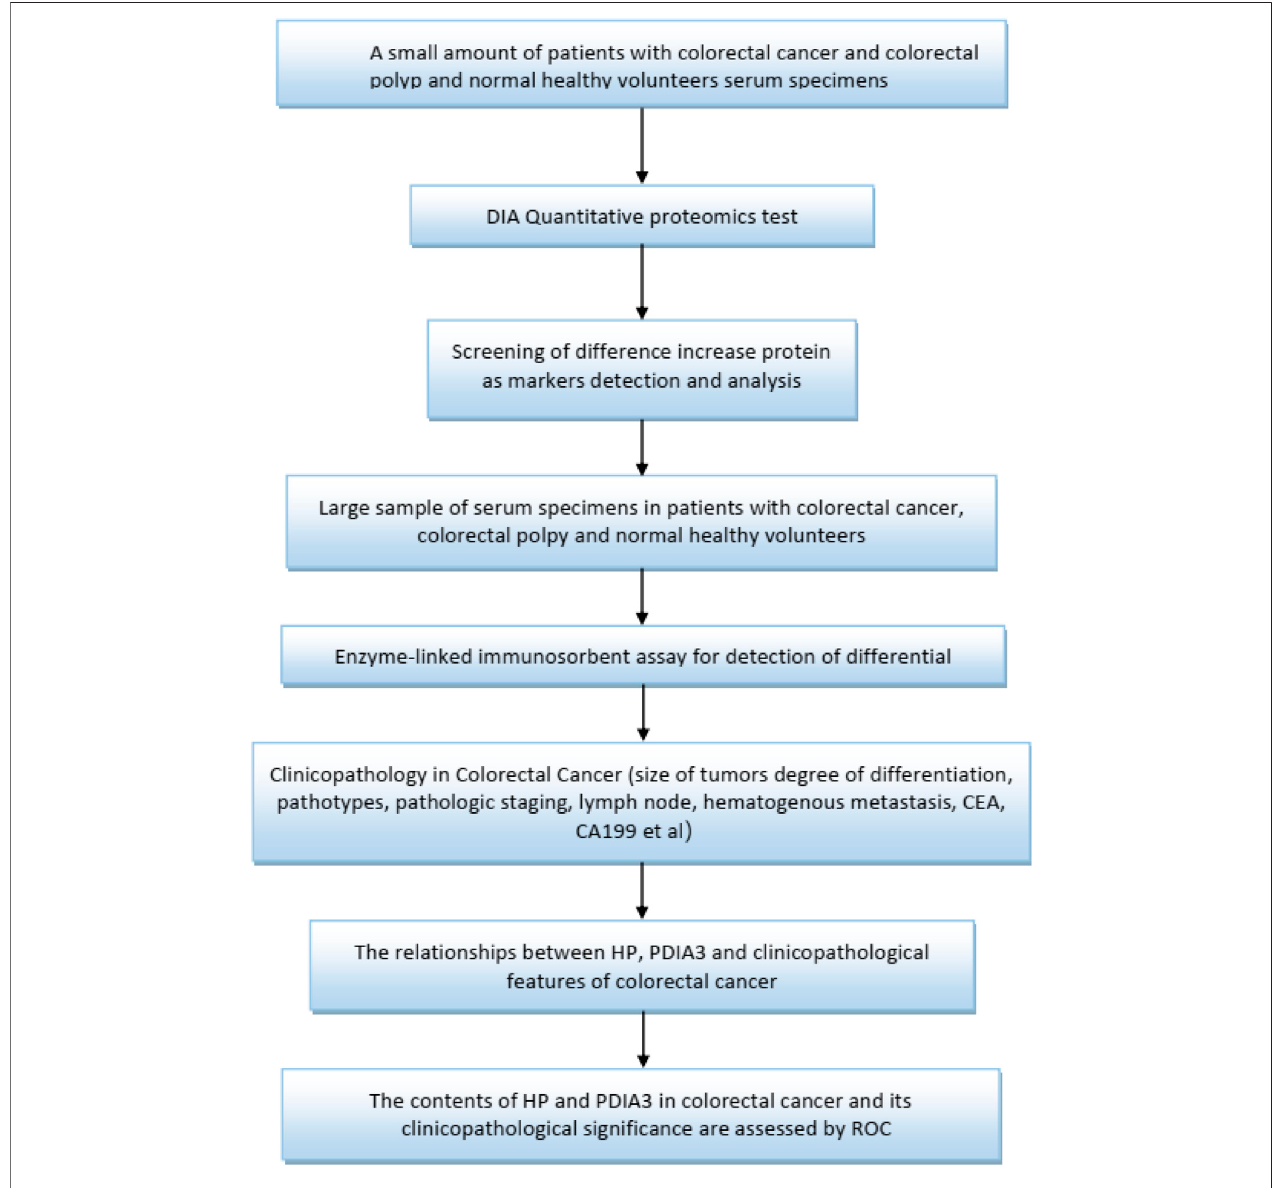
FIGURE 1 | Flow chart of study